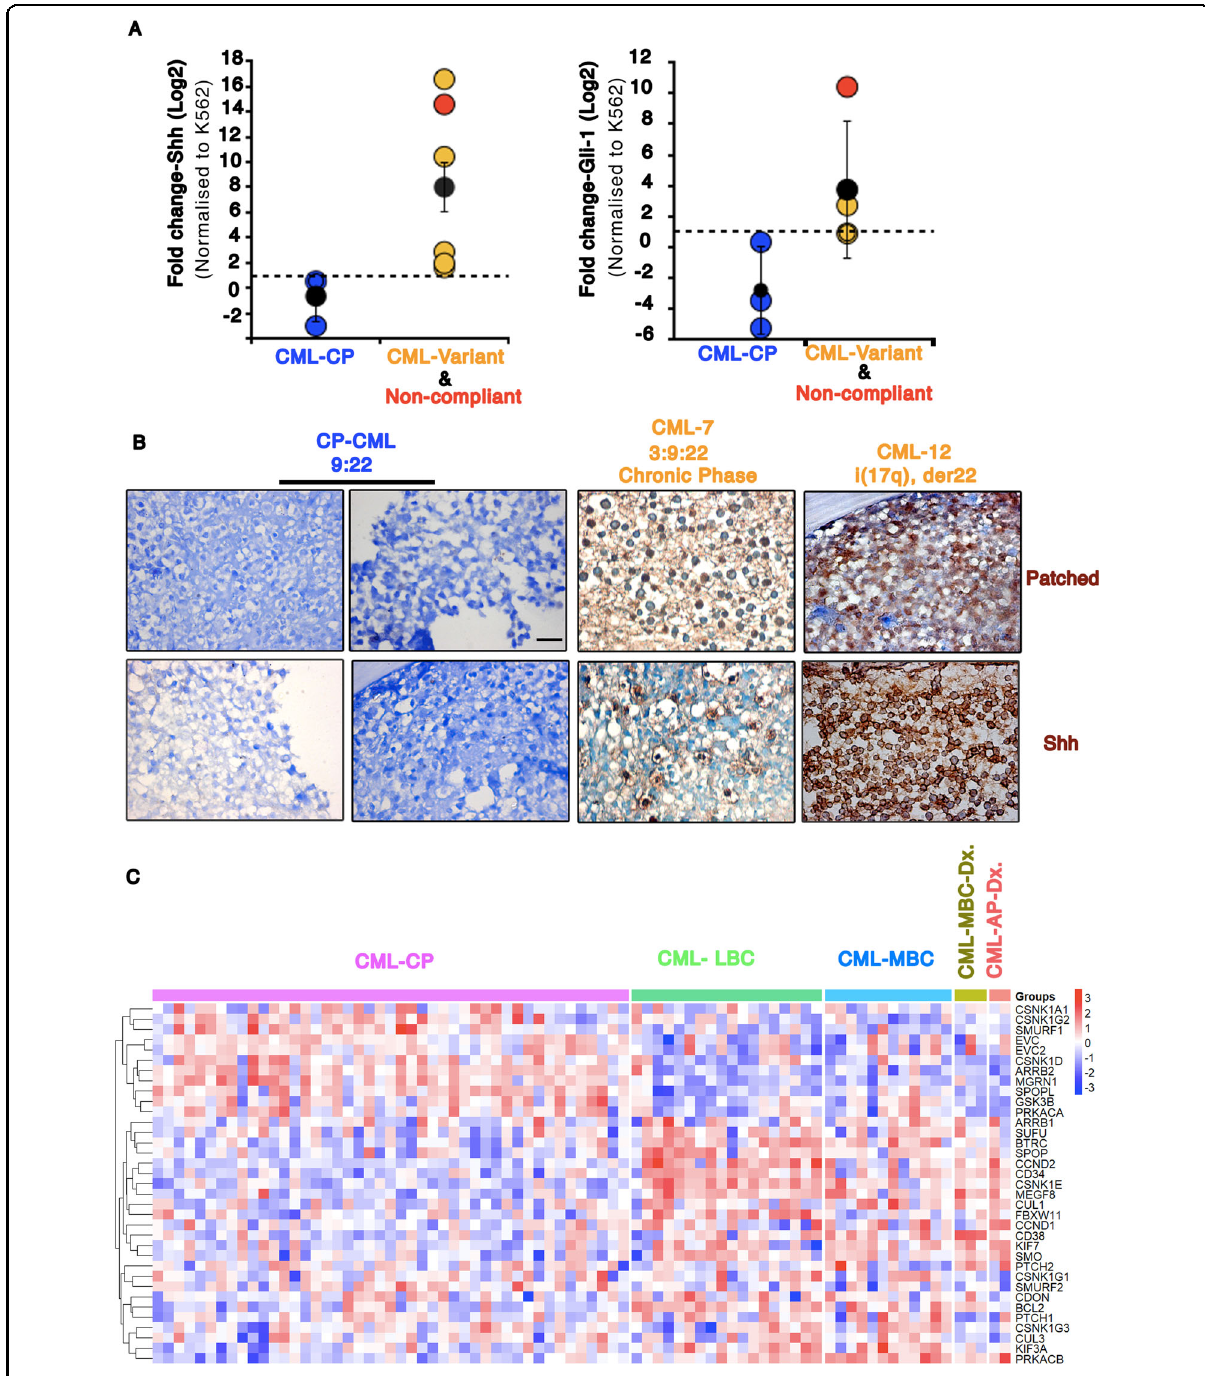
Fig. 1 Shh expression and signaling are signi fi cantly upregulated in CML-variants and non-compliant patients. A Graph representing fold change in Shh and Gli1-mRNA (in log2 scale) from chronic phase CML (CML-CP) patients ( n = 3; blue data points); chronic phase CML with variant chromosomal translocation ( n = 5; orange) and non-compliant patients ( n = 1; red) using RT-PCR. Reference line (black dotted line) represents the expression in normalizing control (K562 cells). P values, *<0.05. Statistical analysis done using t -test. B Immunohistochemistry for Shh and Patched1 using bone biopsy samples of CML patients in CML-CP (9:22; CML-3&8) and chronic phase CML with variant chromosomal translocation (CML-7, CML12). Blue, hematoxylin. Scale bar 20 μ m. C Heatmap showing expression of Shh signaling pathway genes (as per KEGG pathway) using RNA-seq data from high-risk CML patients 1 . Patients were in Chronic Phase at diagnosis (CP Dx.) with progression to lymphoid blast crisis (LBC) or myeloid blast crisis (MBC). Three patients were in MBC at diagnosis (MBC Dx.). Two patients were in accelerated phase at diagnosis (AP Dx.) and progressed to MBC. The gene expression pro fi les depict the clear distinction between CML-CP from other